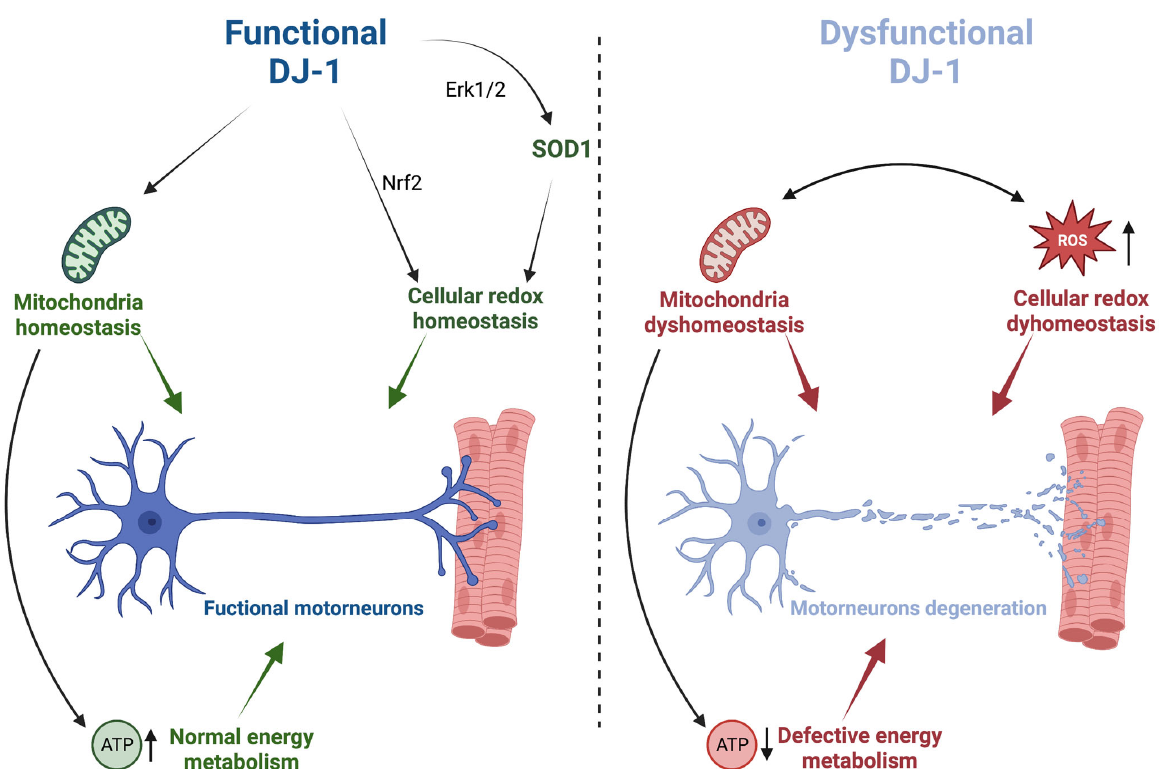
Figure 1. The physiological functions of DJ ‐ 1 possibly affected in ALS pathology. DJ ‐ 1 participates in the maintenance of mitochondrial and cellular redox homeostasis. These functions are fundamental to sustaining the high energetic demand of MNs without producing excessive levels of ROS, and collectively, they contribute to MNs’ healthiness ( on the left ). Alterations in DJ ‐ 1 physiological functions might affect mitochondria functionality, reducing the levels of ATP below MNs’ needs. At the same time, mitochondria dysfunctions might promote increased levels of ROS. Altogether, these alterations might constitute a pathological background enhancing the probability of developing ALS ( on the right ) (created with BioRender.com, accessed on 6 April 2023).